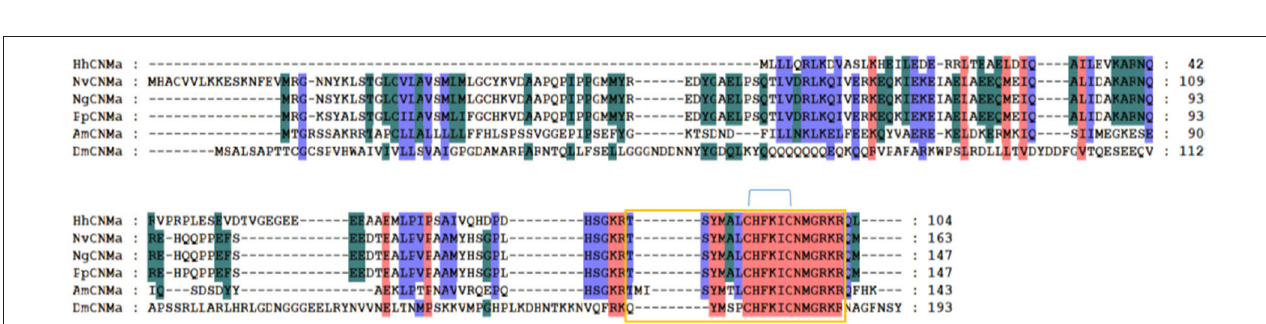
FIGURE 3 | Multiple sequence alignment of the CNMamide (CNMa) from H. hebetor (HhCNMa), A. mellifera (AmCNMa, XP_001121373.1), D. melanogaster (DmCNMa, AAF47581.2), N. vitripennis (NvCNMa, XP_016840002.1), Nasonia girault (NvCNMa, GBEC01006871.1), and P. puparum (PpCNMa, PPU11419-RA). Amino acid residues common in at least four sequences are highlighted. The blue lines above the sequences denote positions of the three disulfide bonds in CNMa. The orange boxes indicate the mature